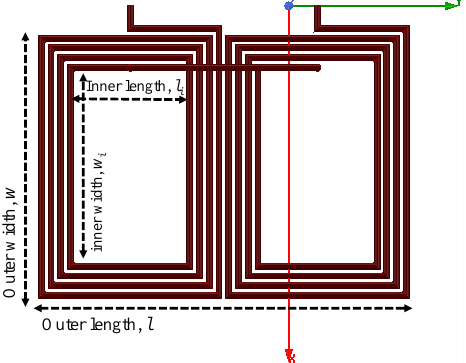
Figure 6. Dimensions of the DD charging